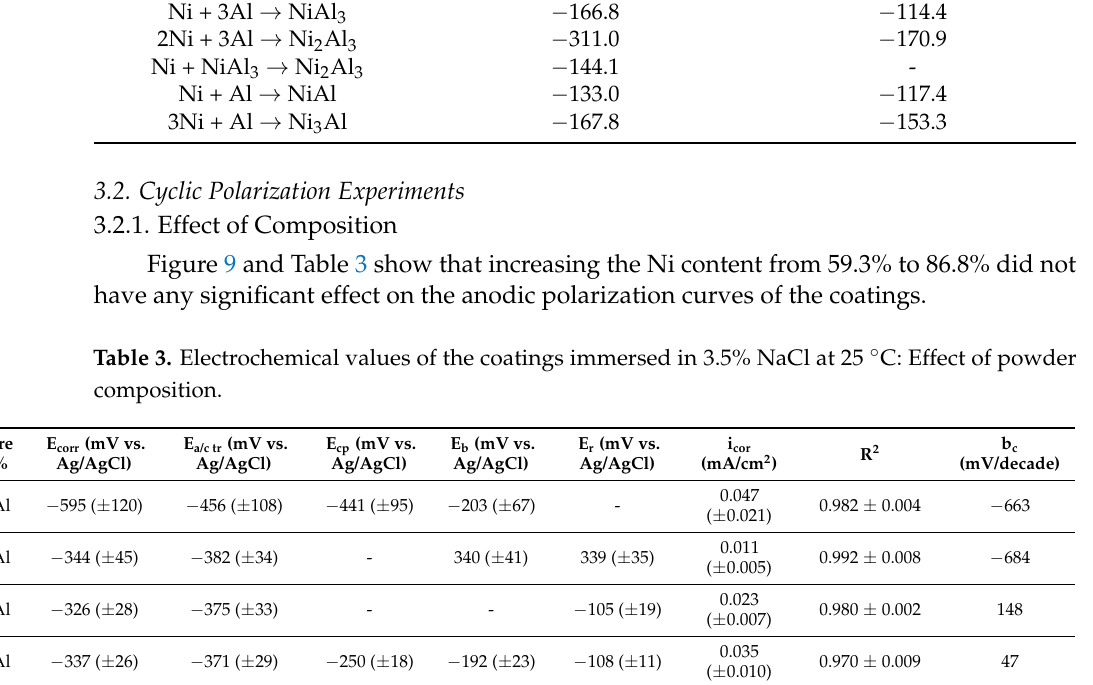
Table 2. Gibbs free energies of formation and free enthalpies of formation of some nickel aluminides [53,54,56,57]. Gibbs Free Energy of Reaction